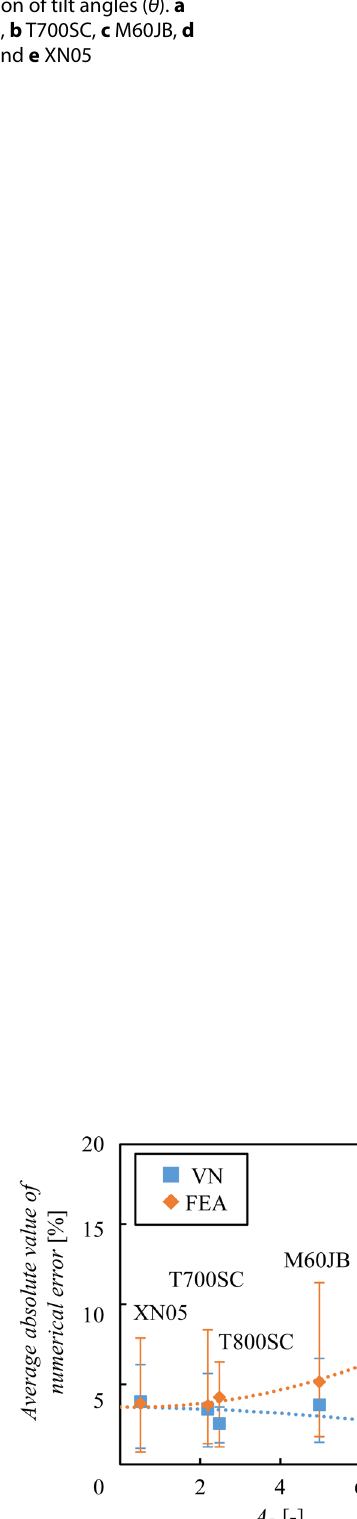
Fig. 12 Numerical errors as a function of tilt angles ( θ ). a